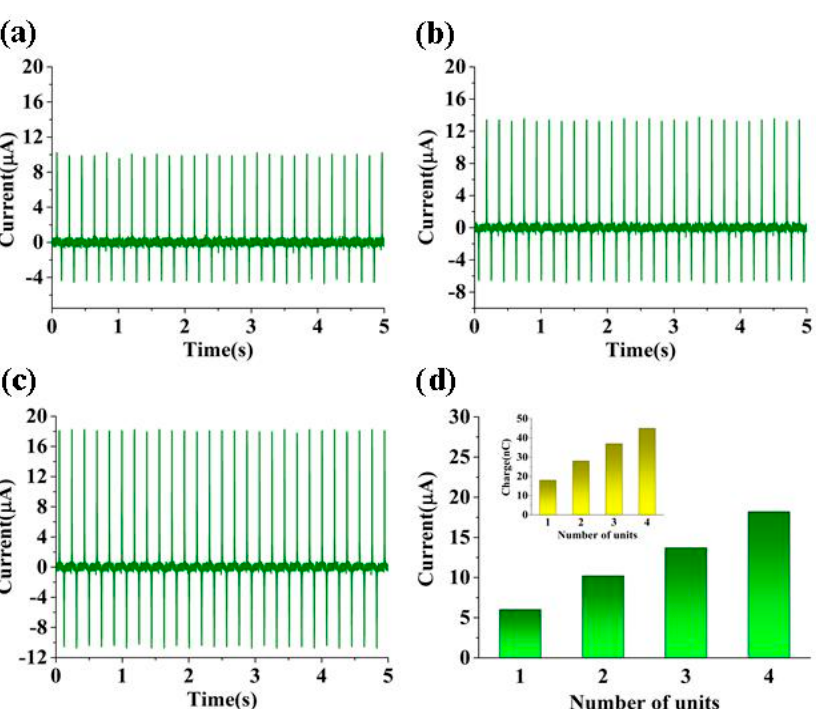
Figure 4. Characterization of a CN-TENG output with different unit numbers. The approximate I SC value of the CN-TENG with ( a ) two units, ( b ) three units, and ( c ) four units. ( d ) Comparison of output performance.